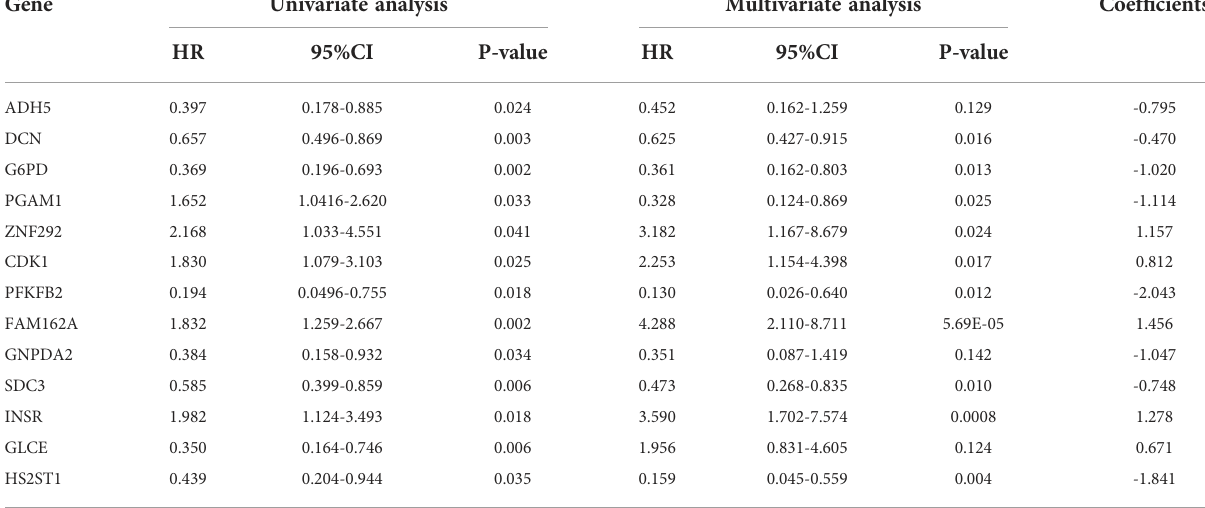
TABLE 2 Characteristics of genes in the prognostic model.